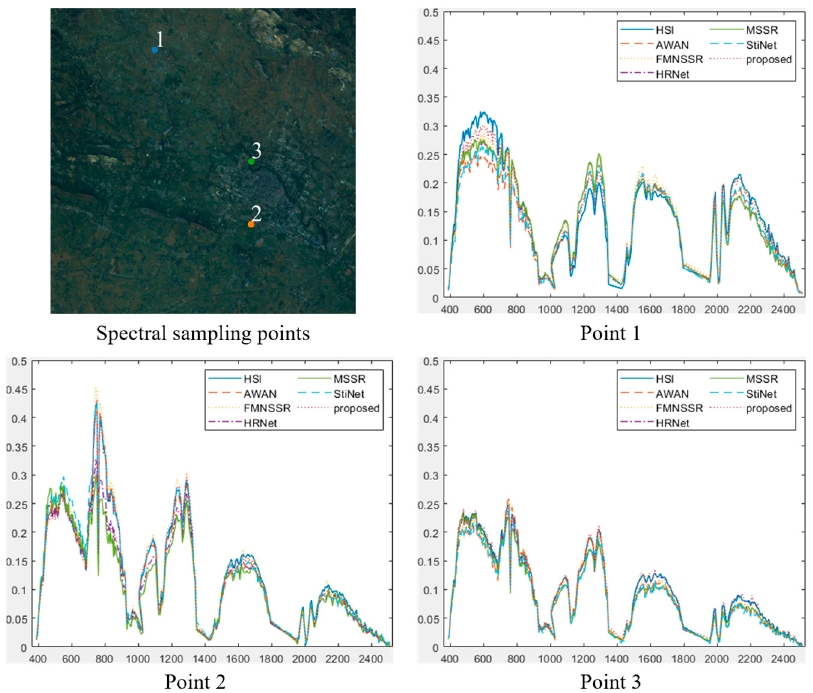
Figure 10. Spectral curve comparison at selected points in the GF5 data, showing the results for the various methods. various methods.